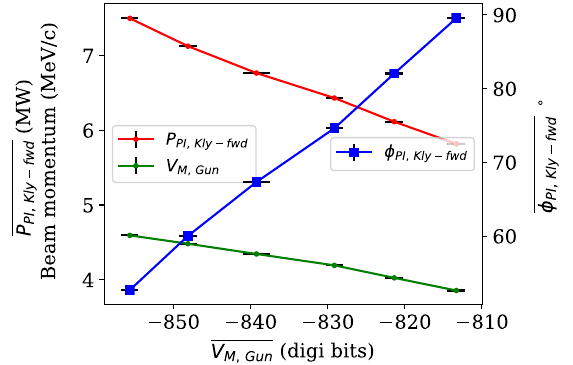
FIG. 44. Variation in output rf power, phase, and beam momentum with modulator cathode voltage.